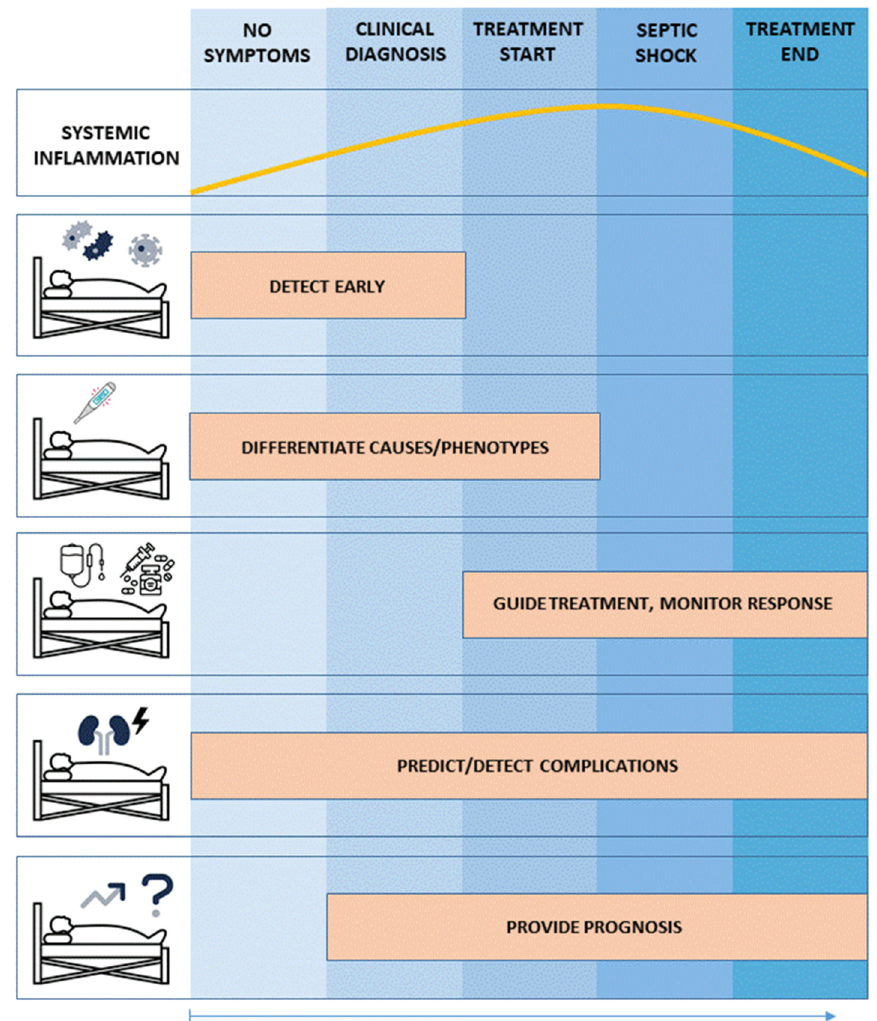
Figure 1. Applications of biomarkers in the clinical pathway of